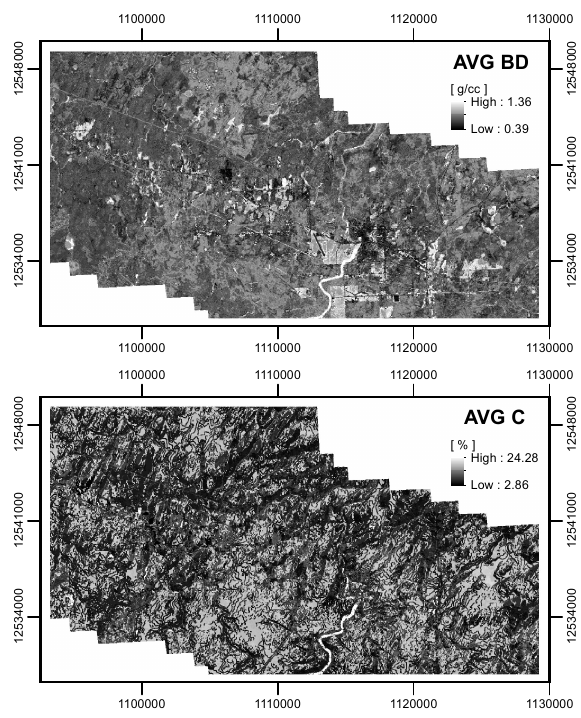
Figure 7. Prediction maps for AVG BD and AVG C for the 0- 15 cm depth layer, from the respective RF models built upon just 5